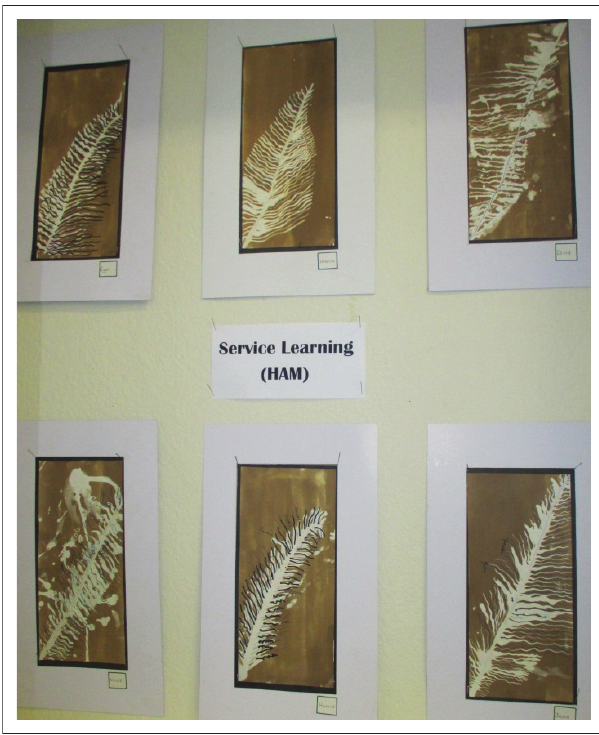
FIGURE 1: Frist drawing lessons mounted and exhibited.